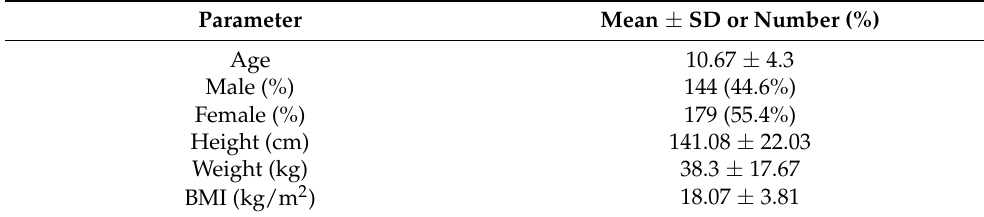
Table 1. Characteristics of the study group ( n =